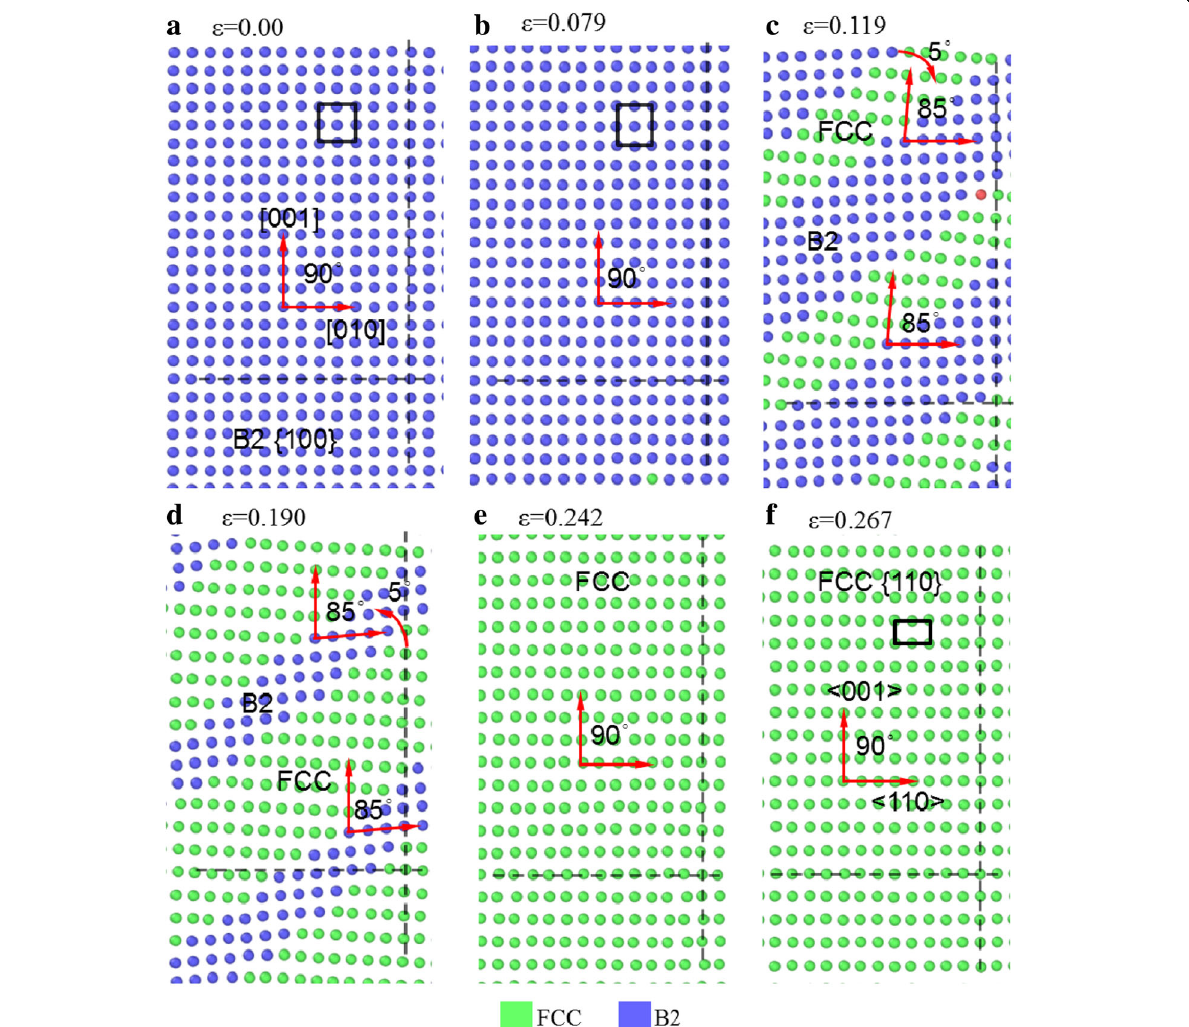
Fig. 7 yoz slices of [001] sample under tension at different strains, colored with a local lattice structure, with blue, green, and red representing B2, FCC, and amorphous phases,